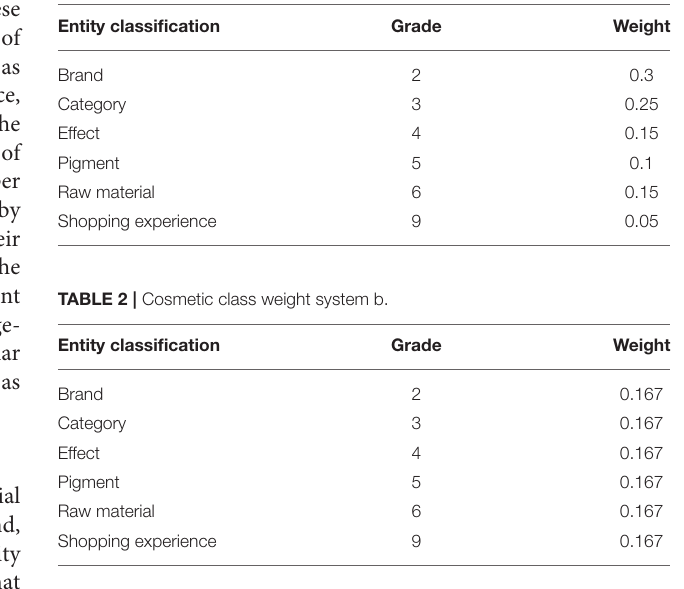
TABLE 1 | Cosmetics class weight system a.